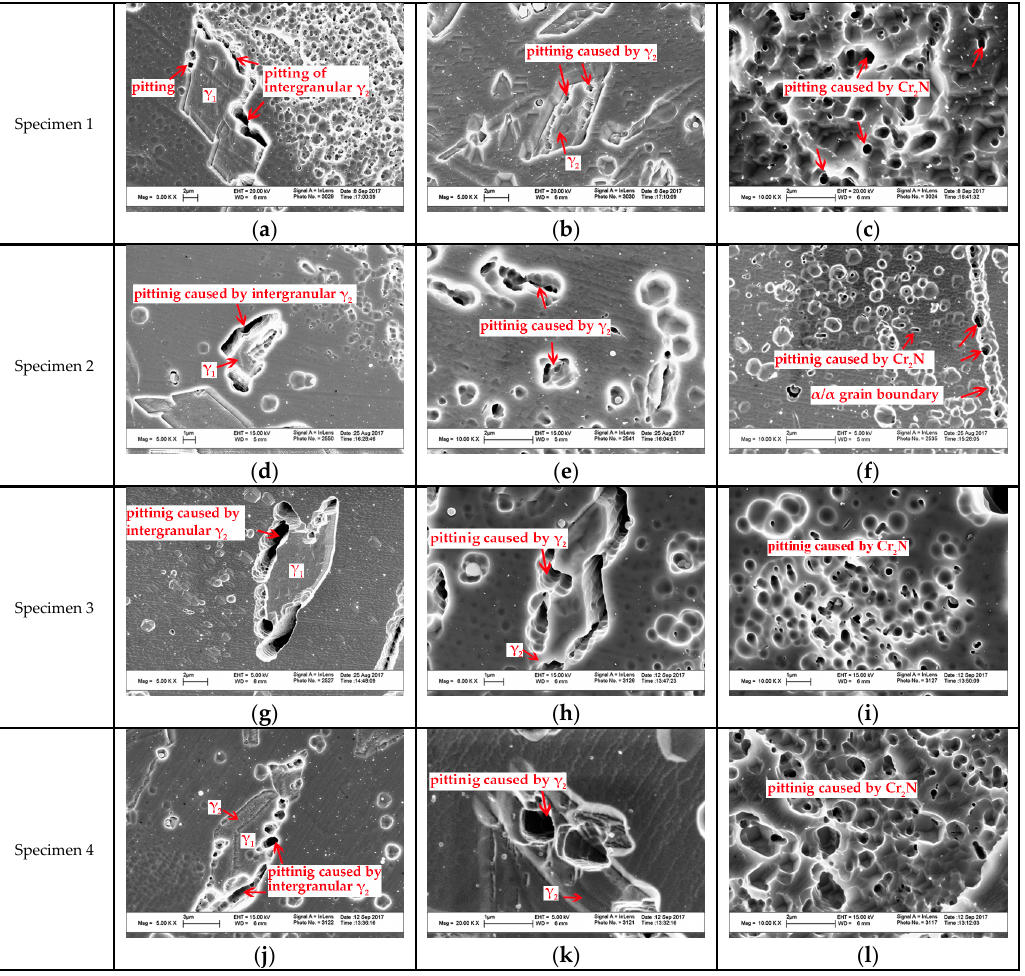
Figure 13. SEM images of pitting morphologies of each specimen after electrochemical polarization test: ( a – c ) of Specimen 1; ( d – f ) of Specimen 2; ( g – i ) of Specimen 3 and ( j – l ) of Specimen 4.